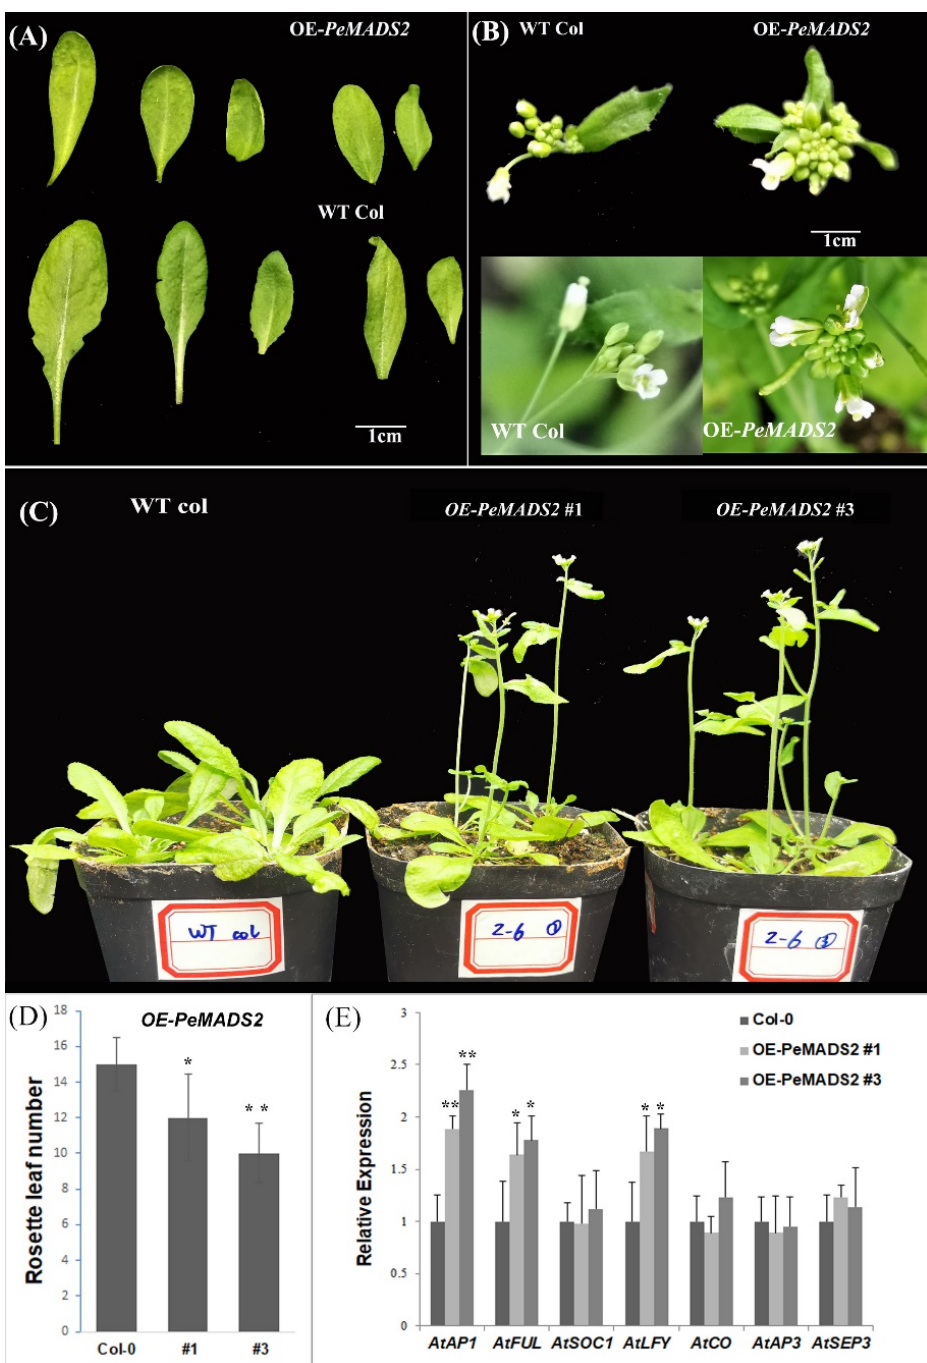
Figure 4. The early flowering phenotype of OE- PeMADS2 in Arabidopsis . ( A )The leaves of OE- PeMADS2 transgenic and WT Arabidopsis plants. ( B ) The floral organs of OE- PeMADS2 transgenic Arabidopsis and wild-type plants. ( C ) Phenotypes of overexpressing PeMADS2 transgenic lines (OE- PeMADS2 #1, #3) and wild-type (WT) plants as control under LD conditions. ( D ) Flowering time was scored as the number of rosette leaves under LD conditions. ( E ) Transcription levels of AP1 , FUL , LFY , CO , AP3 , SOC1 , and SEP3 in WT and transgenic plants. Arabidopsis Actin or TIP41 was used as the internal reference gene. Mean ± SD of three biological replicates is presented. Asterisks indicate a significant difference between transgenic and WT plants (* p ≤ 0.05, ** p ≤ 0.01 , t ’s test).